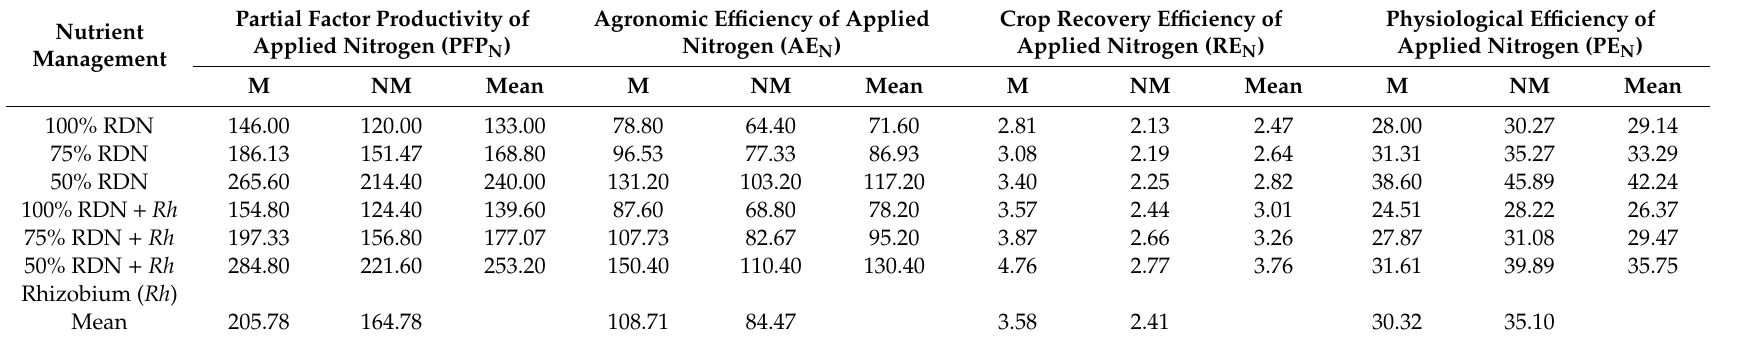
Table 8. E ff ect of soil covering and nutrient management on PFP N , AE N , RE N and PE N of peanut in